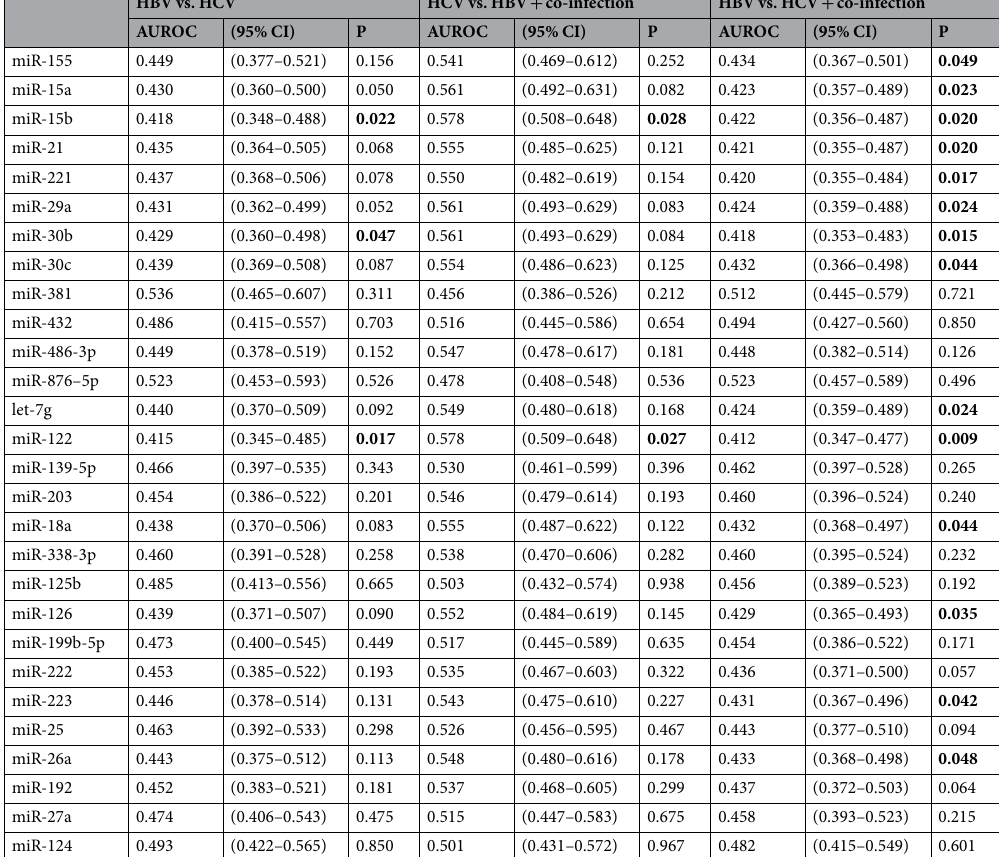
Table 3. Different circulating miRNA levels were observed in liver cirrhotic patients with different viral etiology. Particularly, many miRNA have significant difference between “HBV monoinfection” and “HCV + co- infection” patients.